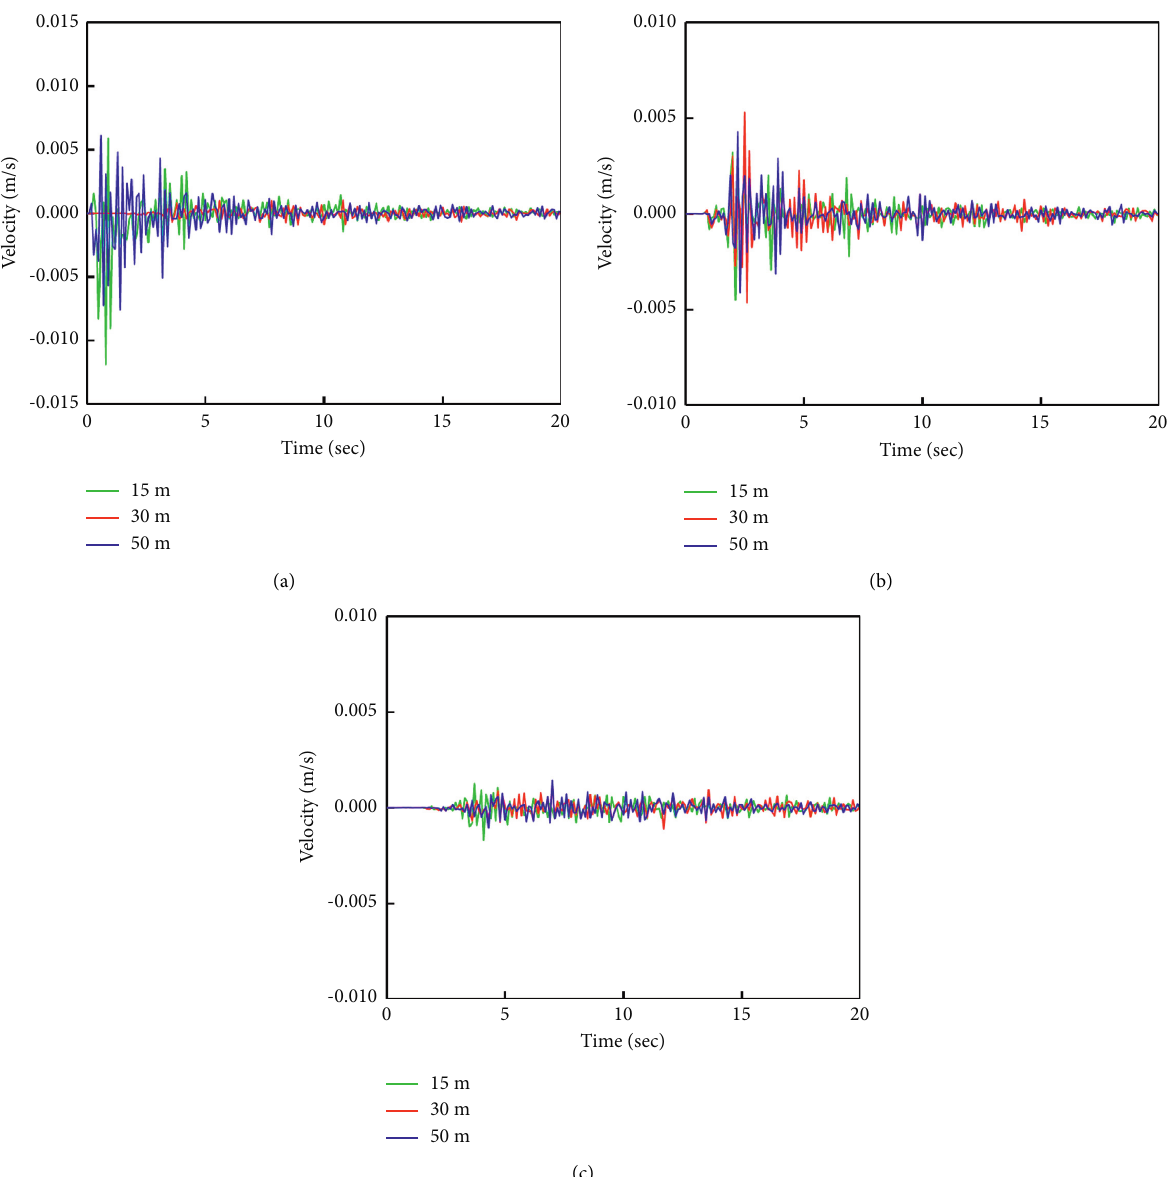
Figure 10: Comparison of the time-history curves for the peak vertical vibration velocities at different measuring points with different distances between the compactors (for the horizontal arrangement): (a) 50m measuring point, (b) 100m measuring point, and (c) 200m measuring energy superposition in the direction of the line con- Figure 14 is the cloud plot showing the distribution of necting the hammer and the measuring point caused by the peak vertical vibration velocity of the ground 2 s after the vertical arrangement had a lesser extent than that of the hammer of the second compactor in a vertical ar- the horizontal arrangement. The vibration velocity anal- rangement landed on the ground. It can be seen from the ysis is detailed in Figure 14. figure that when the time interval between the two It can be seen from Figure 15 that of the condition of two hammers was less than 5 s, the tamping energy of the second hammer had a significant influence on the peak vertical vibration velocity of the ground. When the time interval between two hammers was greater than 5 s, the trend of the ground vibration caused by the tamping energy of the second hammer was essentially similar to that of the single hammer compaction case. However, the